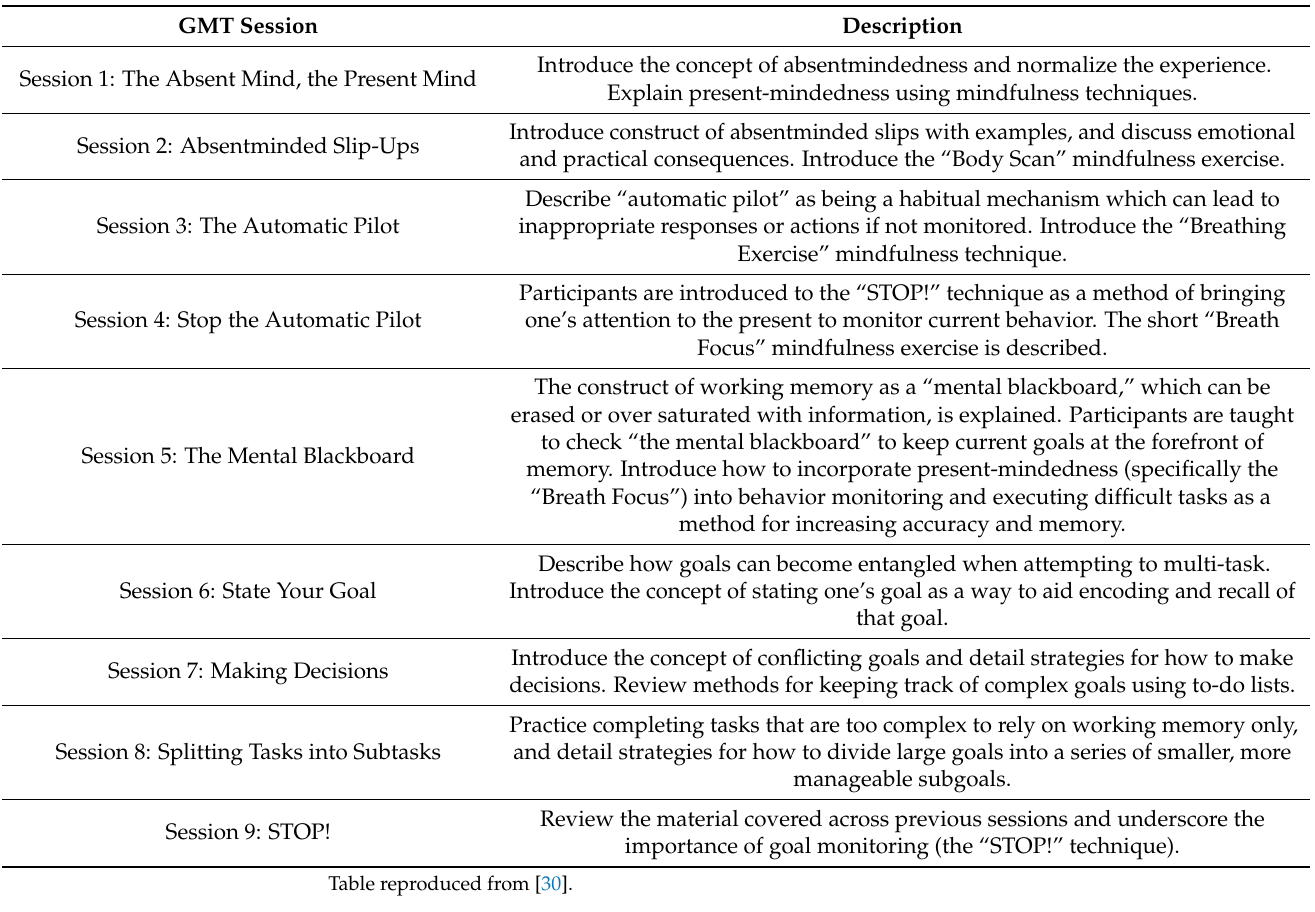
Table 1. Overview of Goal Management Training